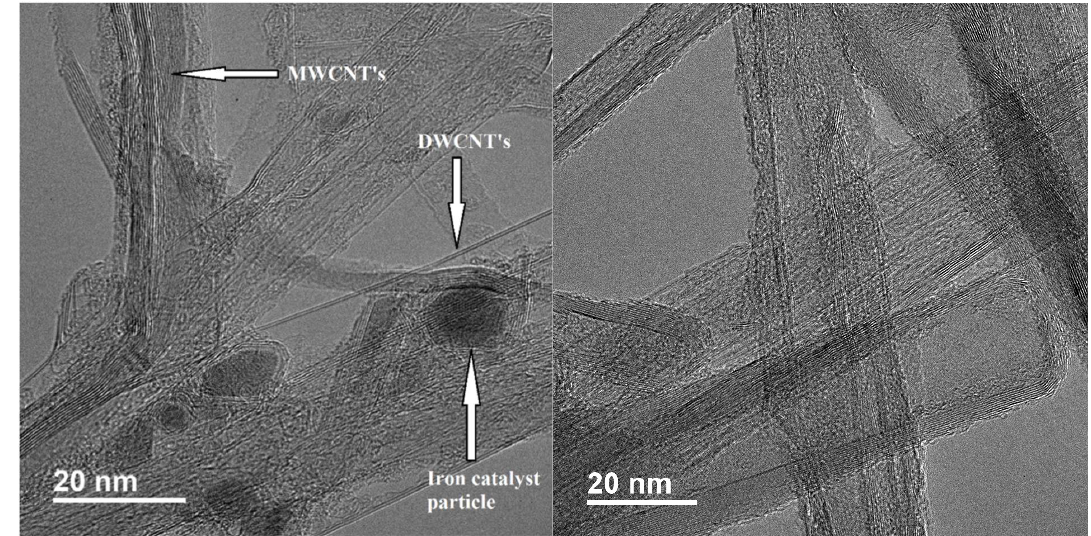
Figure 5. TEM images of as-received MIRALON ® pulp ( left ) and MIRALON ® pulp acid treated for 6 h in 10 M nitric acid at 120 °C ( right ).